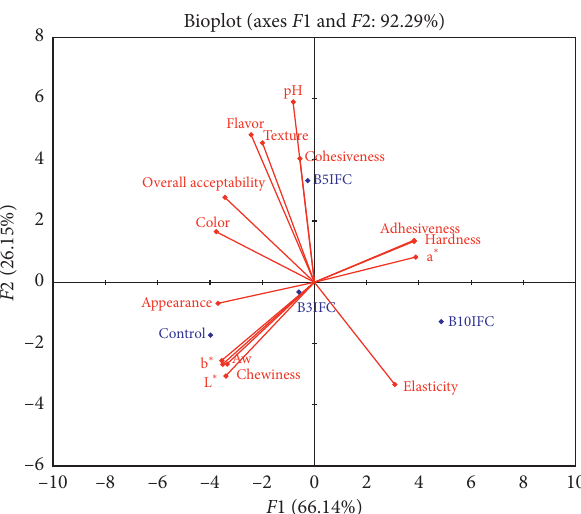
Figure 3: Bioplot representation on the factor plane (PC1–PC2) showing vector distribution of physicochemical analysis (pH and aw), instrument color (a ∗ , b ∗ , and L ∗ ) and texture parameters (chewiness, hardness, elasticity, cohesiveness, and adhesiveness), and sensory characteristics (color, flavor, appearance, texture, and overall acceptability) within score plot of untreated (control) and different treated (B3IFC, B5IFC, and B10IFC) meat